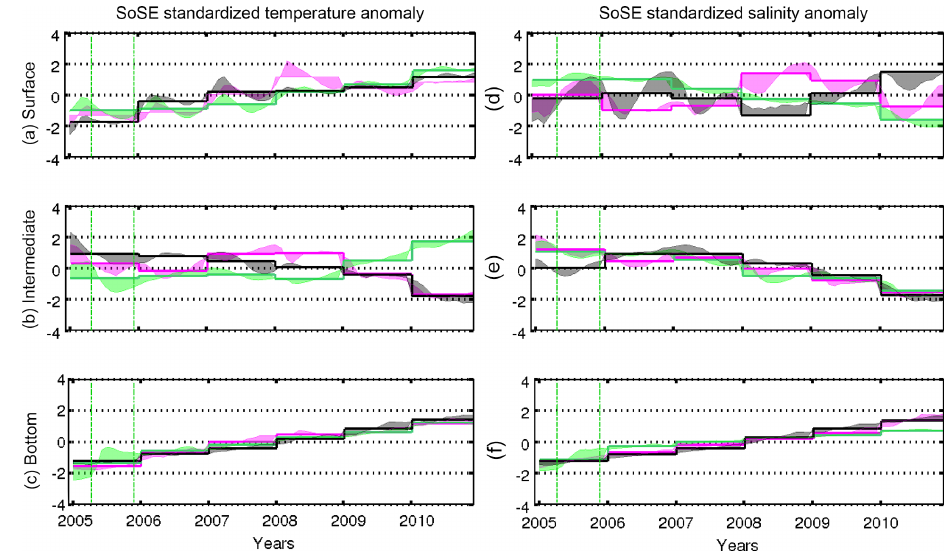
Figure 10. Same as Fig. 8 but for the SoSE reanalysis. Green dashed lines delineate the period in which the polynya stays open in